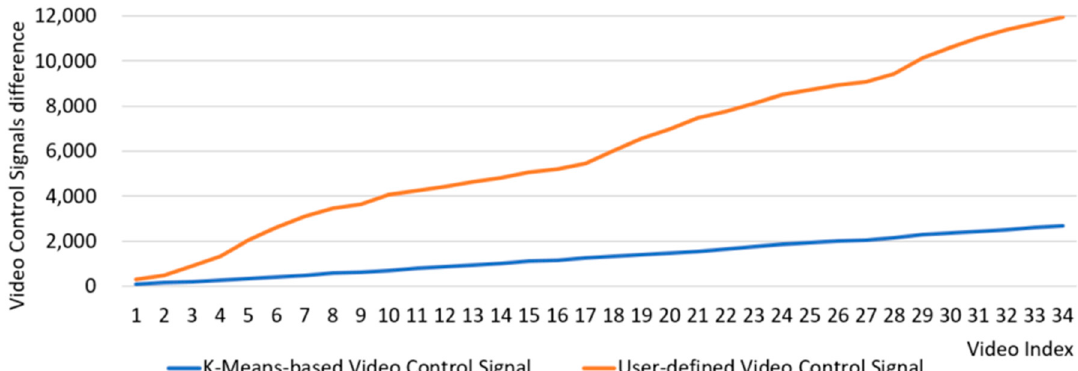
Figure 11. Result of recording the differences between the collected video control signals and the defined video control signals.